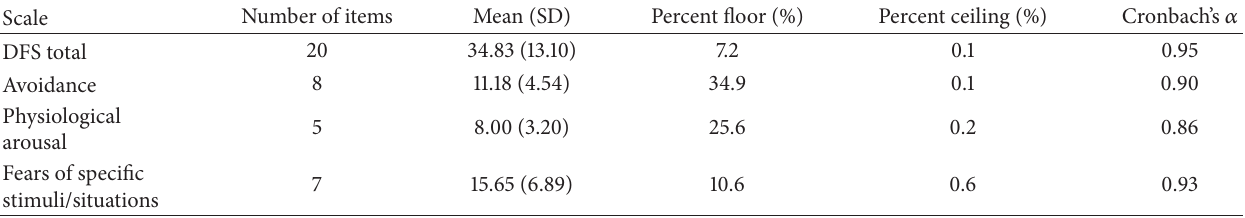
Table 1: Descriptive analysis and Cronbach’s alpha ( 𝛼 ) coefficient for the Brazilian version of the Dental Fear Survey (DFS) ( 𝑛 = 1,256)